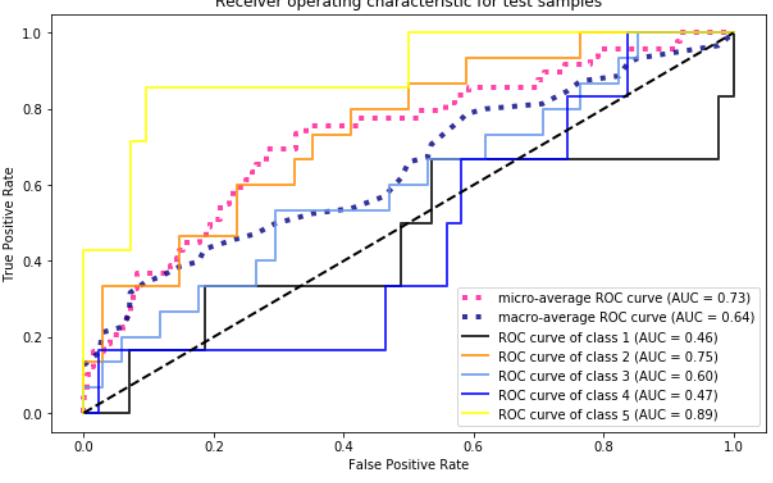
Figure 8. ROC curves for each class of test dataset.